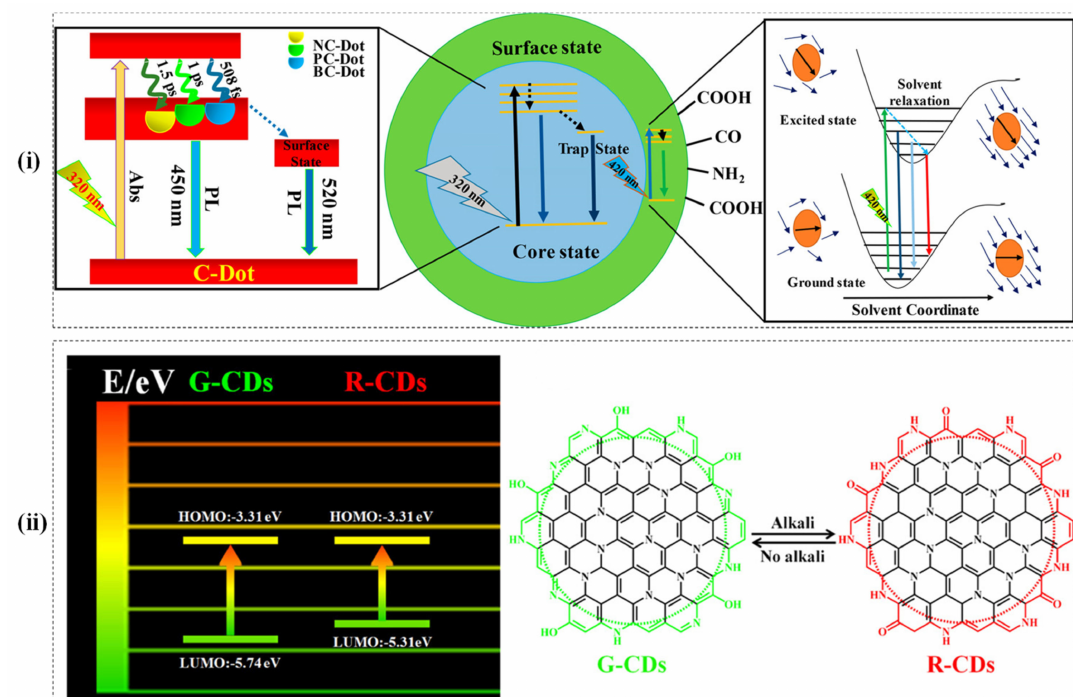
Figure 2. ( i ) Energy levels (HOMO and LUMO) of G-CDs and R-CDs (left side); Luminescence mechanism (right side) [92] (Reproduced with permission). ( ii ) Excited-State for Doped C-Dots at Core State and Surface State, [51] (Reproduced with